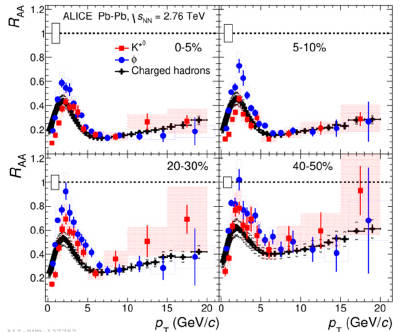
Figure 6. ρ (770) 0 / π ratio as a function of < d N ch / d η > 1/3 in pp and Pb-Pb collisions at √𝒔 𝐍𝐍 = 2.76 TeV. The statistical uncertainties are shown as bars. Boxes show systematic uncertainties. The shaded boxes are the multiplicity uncorrelated systematic uncertainties. The widths of the boxes are fixed to arbitrary values for better visibility. Figure taken from [7].